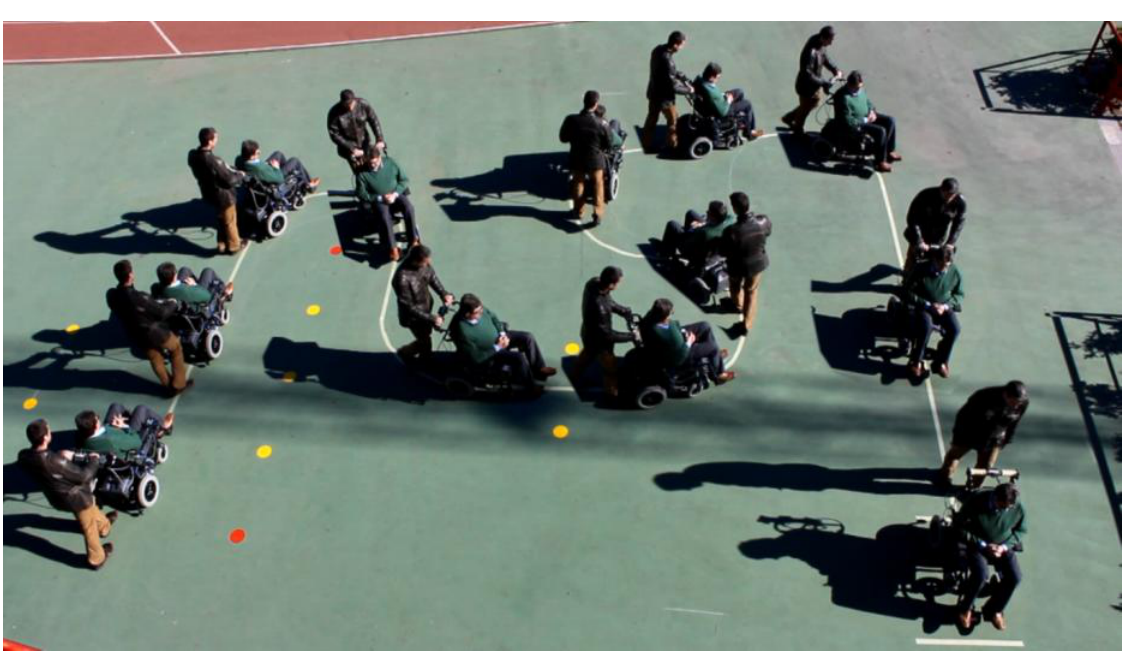
Figure 23. Test path: fourth user.